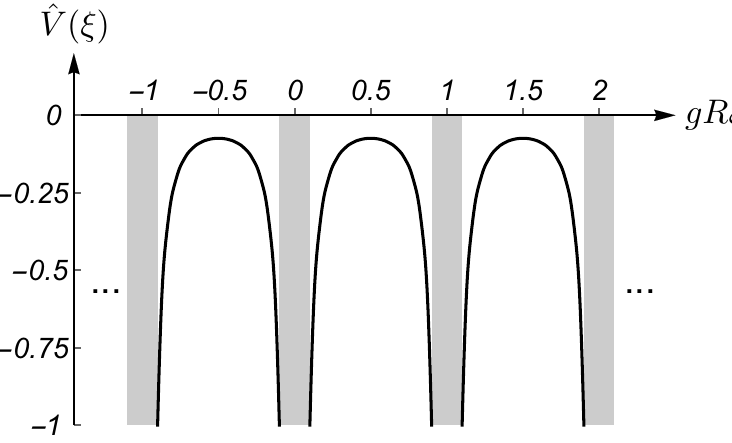
Figure 3 . Wilson-line potential, normalized to its value at the border to the tachyonic region, p which is chosen to have the width (cid:1) = 2 gfR 2 = 0 : 2 (see